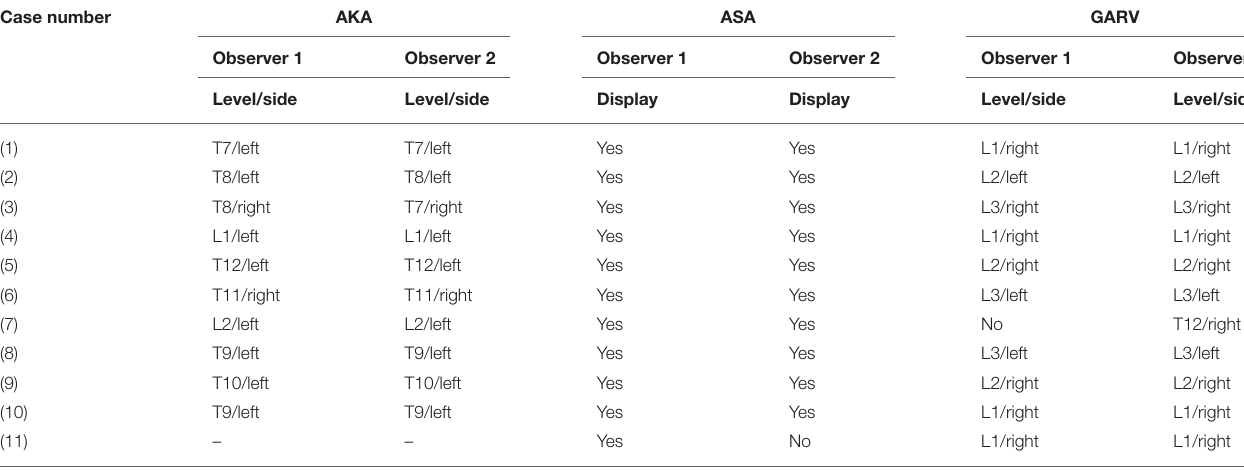
TABLE 1 | The interobserver agreement of AKA and GARV and the display rate of ASA on time-resolved angiography with stochastic trajectories between two observers. Case number